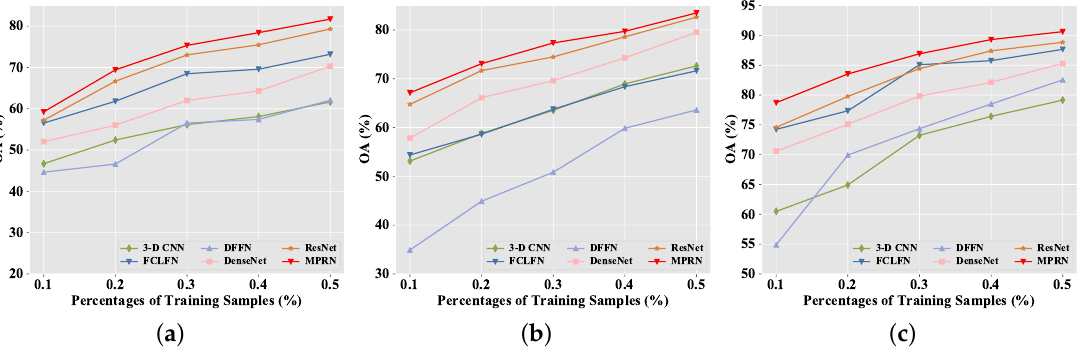
Figure 11. Overall classification accuracies (in %) obtained by 3-D CNN [32], FCLFN [56], DFFN [35], DenseNet [57], ResNet [46] and MPRN when considering different percentages of training samples on the ( a ) Indian Pines, ( b ) Houston University and ( c ) KSC data